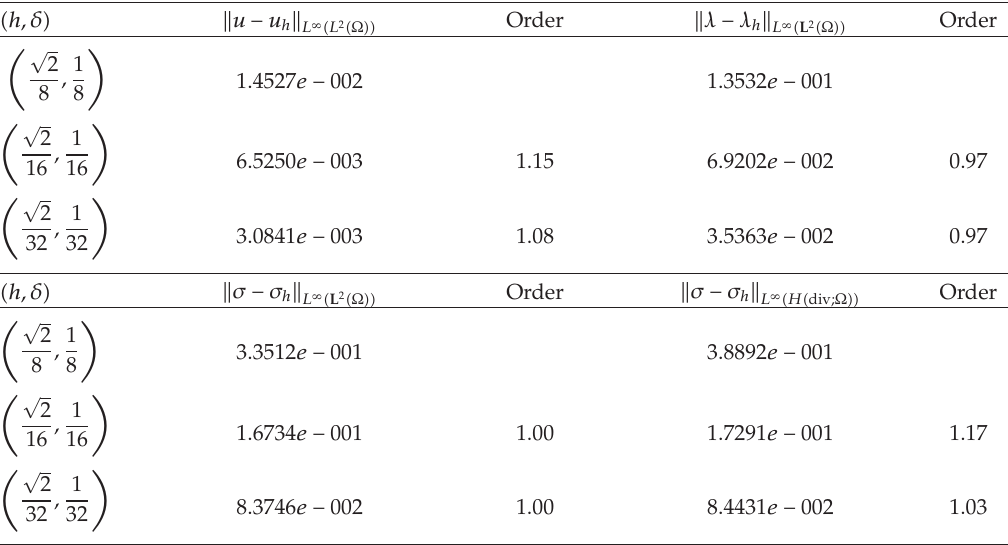
Table 1: The errors and convergence